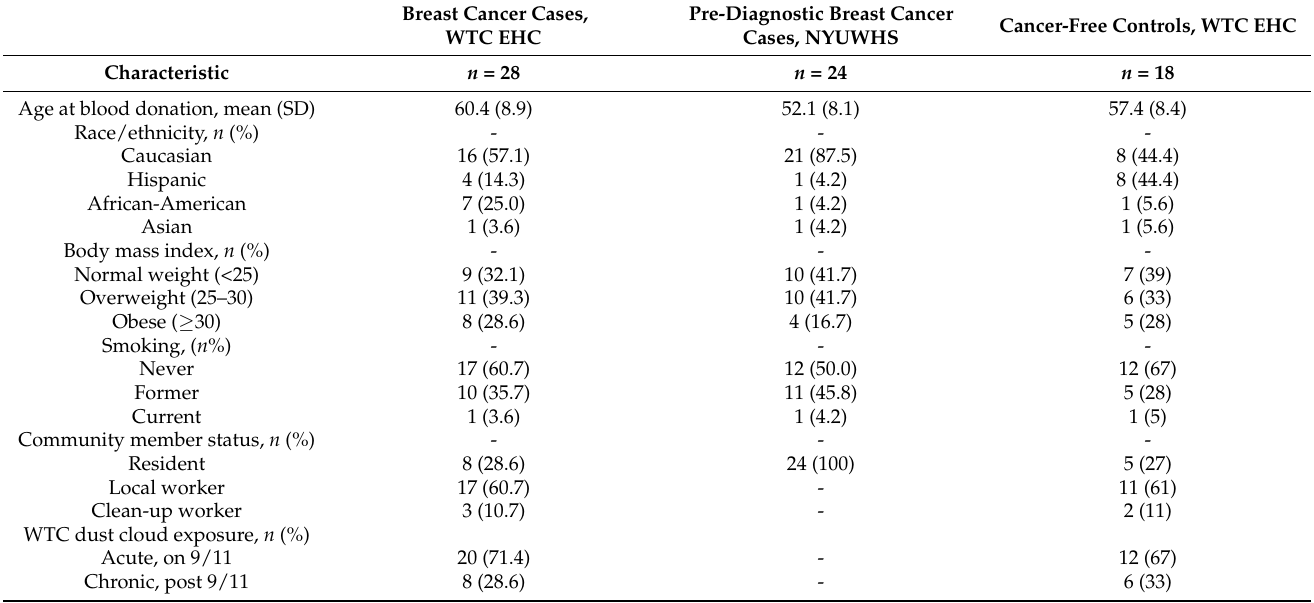
Table 1. Descriptive characteristics of the WTC-exposed (WTC EHC) breast cancer cases, unexposed (NYUWHS) pre-diagnostic breast cancer cases, and WTC-exposed cancer-free women. Breast Cancer Cases, Pre-Diagnostic Breast Cancer Cancer-Free Controls, WTC EHC WTC EHC Cases, NYUWHS Characteristic n =